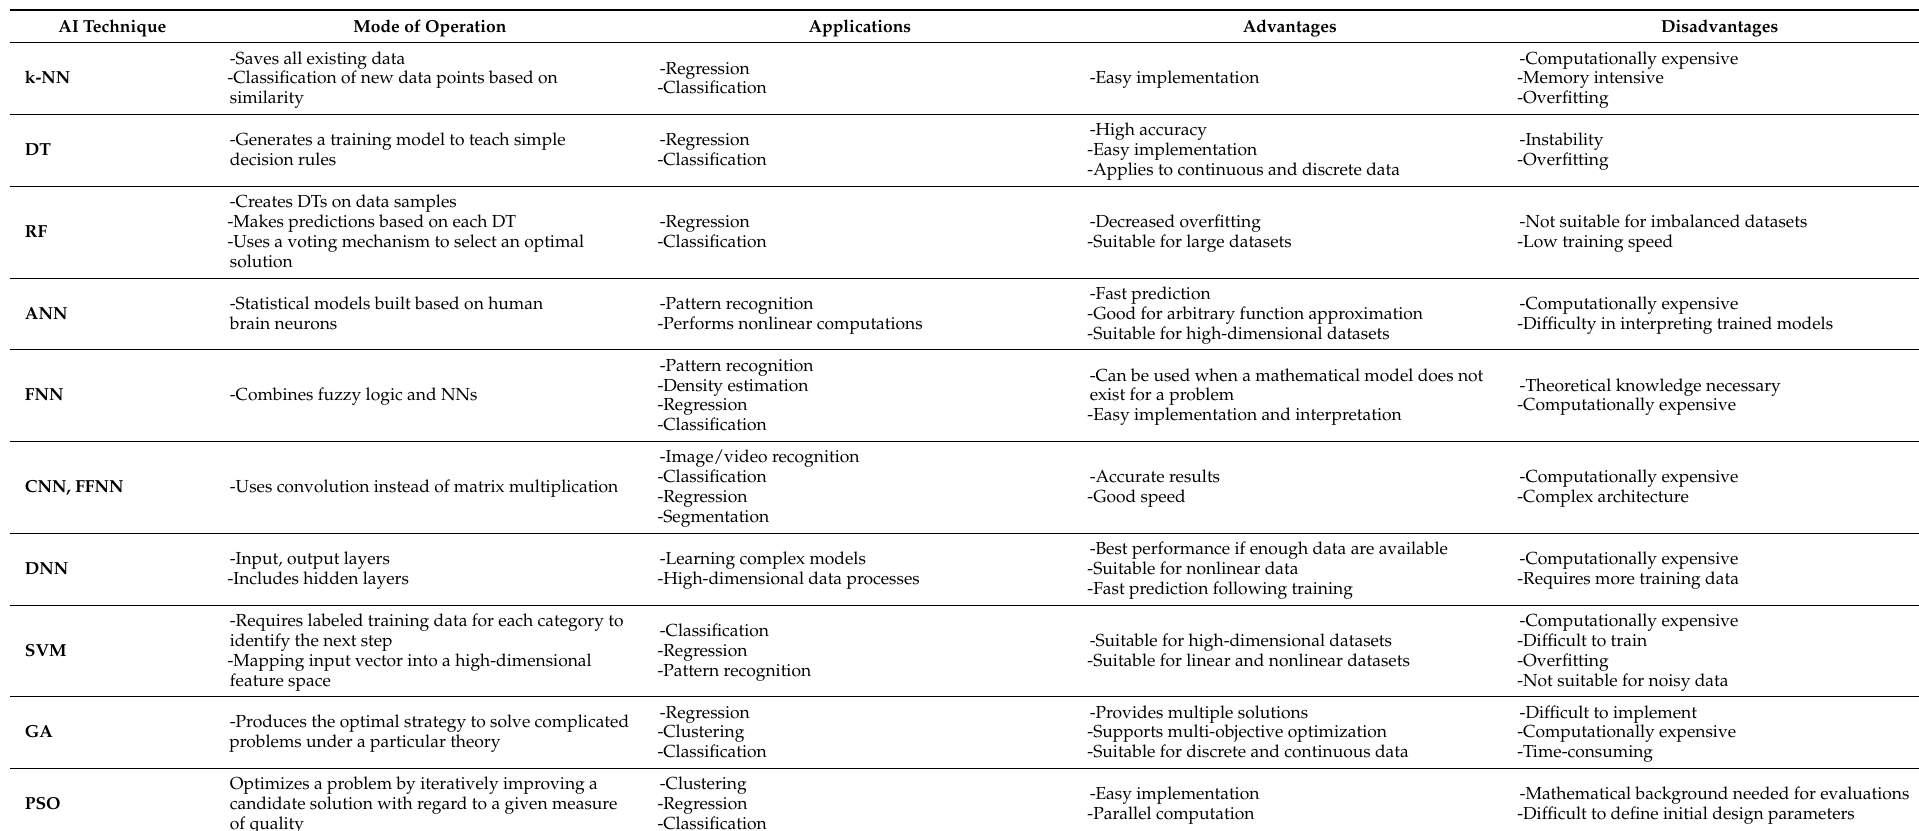
Table 3. Summary of artificial intelligence (AI) techniques commonly used in membrane fouling prediction (adapted from